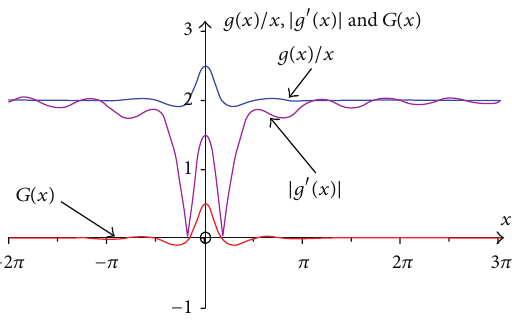
Figure 5: Functions 𝑔(𝑥)/𝑥 , 𝐺(𝑥) and |𝑔 󸀠 (𝑥)| .